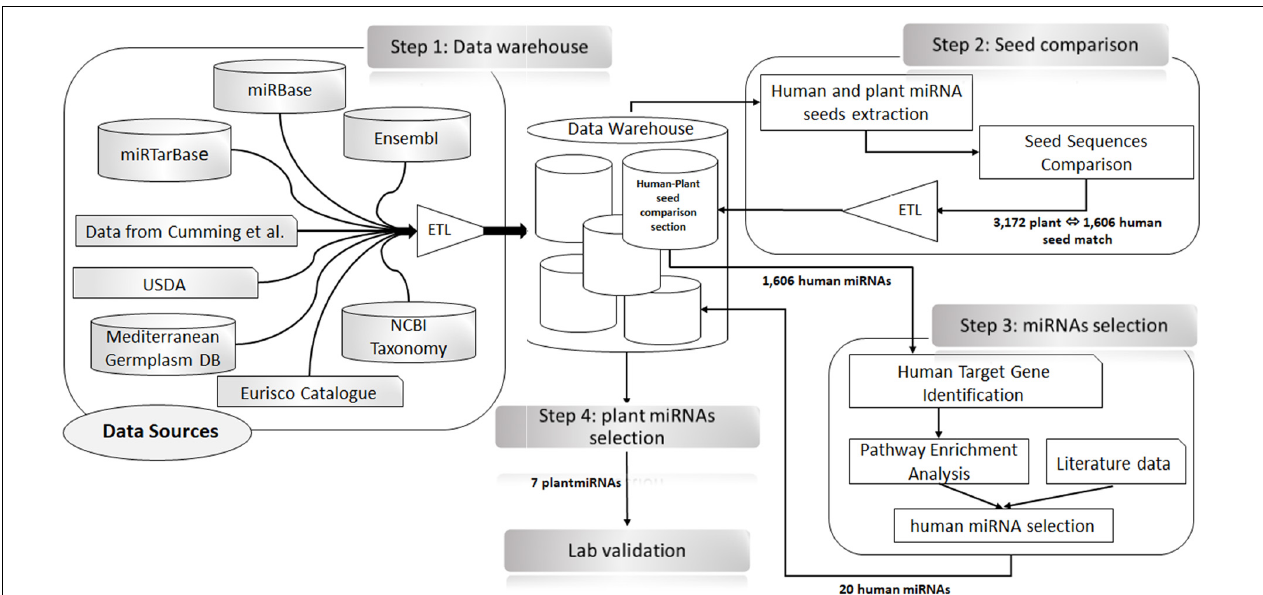
FIGURE 1 | Schematic representation of the bioinformatics analysis approach for the selection of plant microRNAs (miRNAs) to be used for transfection experiments. Step 1: Data warehouse—data from external resources (as shown in the scheme) were extracted and integrated into the data warehouse using extraction, transformation, and loading (ETL) procedures. Step 2: Seeds comparison—SQL procedures were used (Issa et al., 2006) to extract, the seed regions of the human and plants miRNA considering the positions 2–7.2–8.3–8.2) to identify the perfect matches between plant and human seed sequences. The results of this analysis (i.e., the official name of the human–plant miRNA pairs, the shared seed sequences, their positions, and the whole sequence) were collected in the Human–Plant Seed Comparison section of the data warehouse. Step 3: miRNAs selection—the 1,606 human miRNAs identified in Step 2 were used to search and extract from miRTarBase the list of their target genes. Only strong experimental evidence (i.e., luciferase reporter assay, Western blotting, and RT-qPCR) were selected. The list of genes obtained was used for an enrichment analysis in Database for Annotation, Visualization and Integrated Discovery (DAVID). The results of this analysis, along with information extracted from the literature, allowed us to identify 20 human miRNAs as best candidates. Step 4: Plant miRNAs selection—the 20 miRNAs, selected in Step 3 were used to search in our data warehouse for plant miRNAs with an identical sequence at the 5 (cid:48) end. In total, seven plant miRNAs were found that were used for the transfection experiments (Step